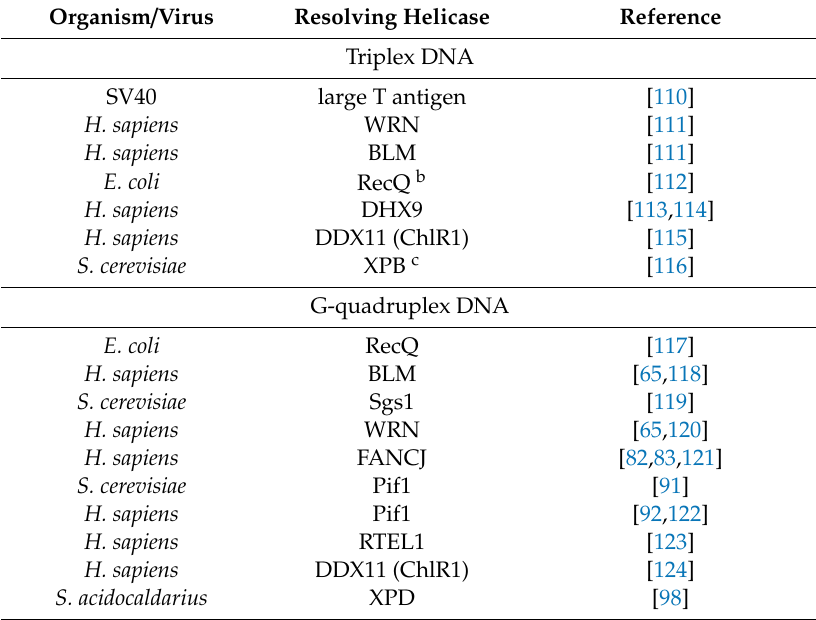
Table 1. Helicases that Resolve Triplex and G-Quadruplex DNA Structures a